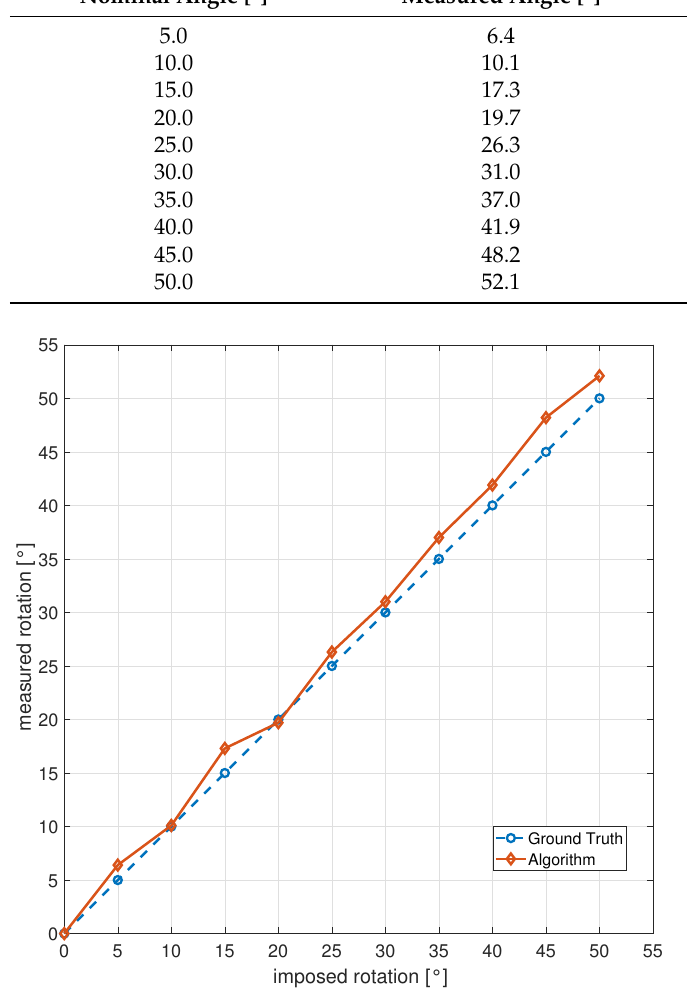
Figure 10. Comparison of the imposed rotations with the measured